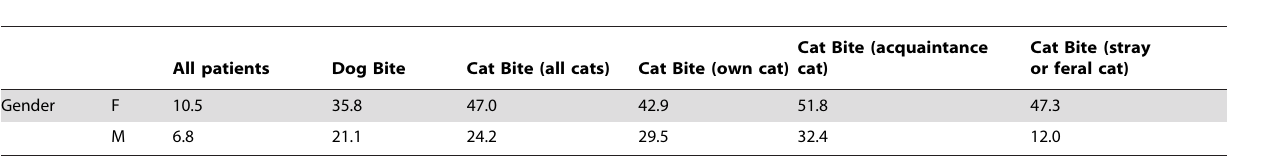
Table 6. Percent probability of having depression given the following conditions.